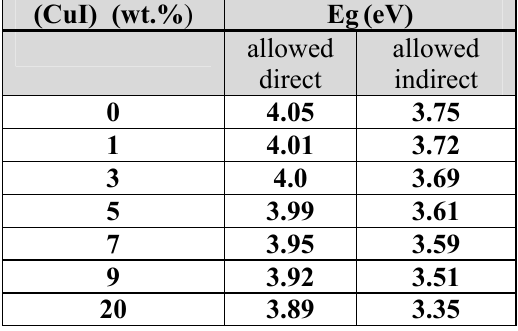
Table 3: Values of optical energy gap for the direct allowed and indirect allowed transition for of PVA/CuI polymer